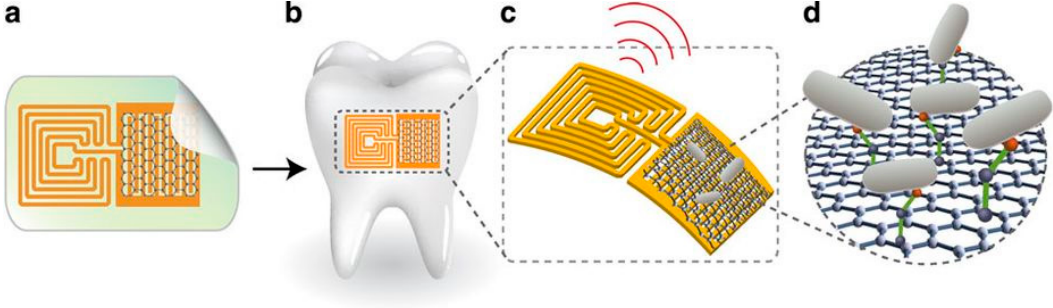
Figure 5. Graphene-based sensor for the remote (wireless) detection of bacteria. ( a ) Schematic representation of the nanosensor, containing a graphene/silk-based biosensor coupled to a resonant wireless coil; ( b ) Transfer of the nanosensor onto a tooth surface; ( c ) Illustration of the wireless signal upon bacterial detection; ( d ) Magnification of the bacterial interaction with the AMP-coated graphene platform. Reprinted by permission from Springer Nature-Nature Communications, from [98]. © 2012 Macmillan Publishers Limited.